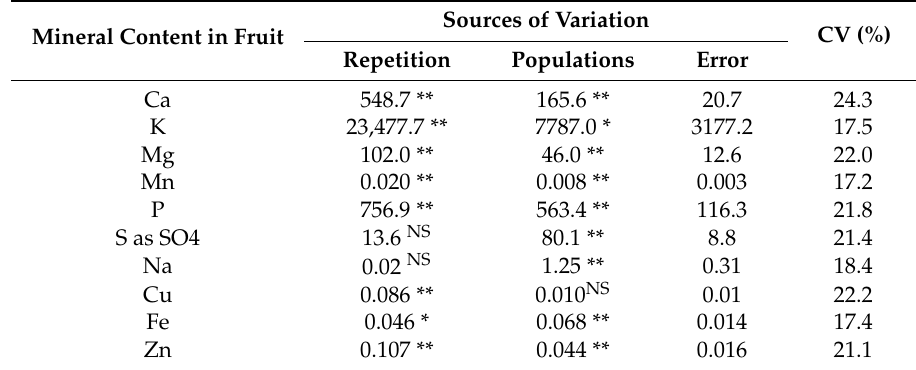
Table 5. Square means significance of mineral content in fruits of eleven tomato accessions from El Salvador, Central America.